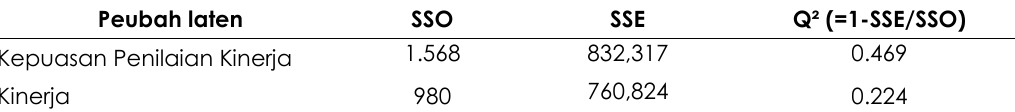
Tabel 8. Nilai Q 2 model